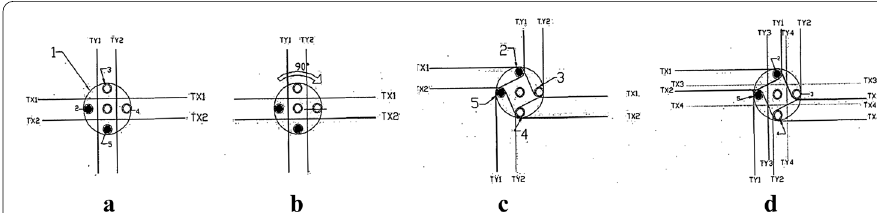
Fig. 10 a – d Interlacement mechanism (Kale 2015). 1—disk, 2–5—thread guides, TX1,TX2,TY1,TY2—wefts,